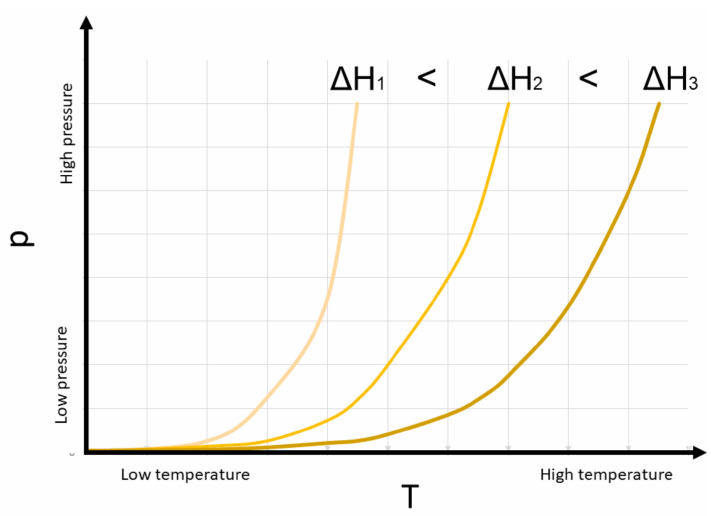
Figure 3. Schematic p–T diagram presenting the equilibrium line for three hypothetic metal hydrides possessing increasing dissociation enthalpy, i.e., ∆ H 1 < ∆ H 2 < ∆ H 3 . The issue of the high thermodynamic stability of several metal hydrides, including MgH 2 , was already investigated at the end of the 1950s and during the